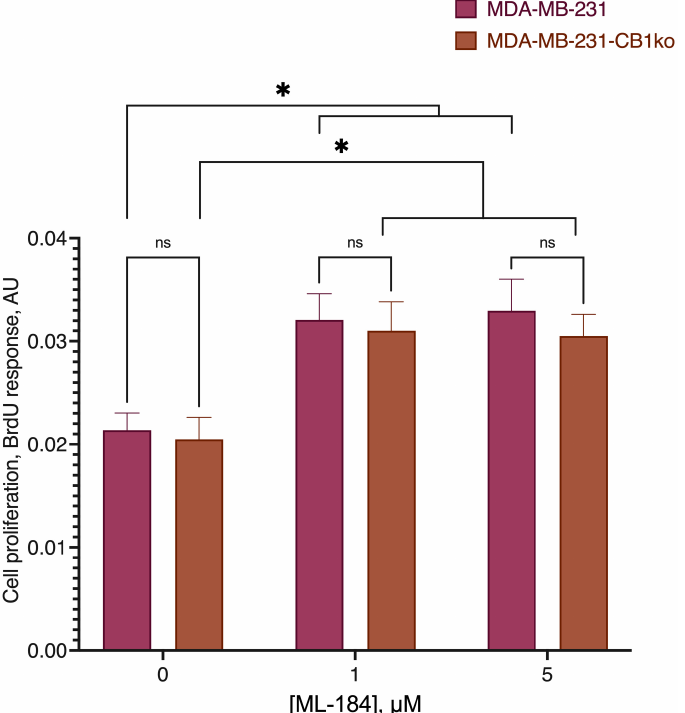
Figure 3. Comparison of the GPR55 agonist ML-184 activity on the original cell line and the line knocked out at the CB1 receptor. *, a statistically significant difference from the control without the substance in the ANOVA test with the Holm–Sidak post ‐ test; ns, not significant. 2.2. CB2 ‐ GPR55 Interaction The next possible receptor pair in the GPR55 functional selectivity was CB2 ‐ GPR55. For this receptor pair, we used the same methodology as for CB1. For this receptor, the target sequence contained the PasI restriction site. The analysis of the CB2 gene fragment from the transfected clones revealed the absence of this site (Supplement Figure S3), which indicated that the target gene was modified in several clones.